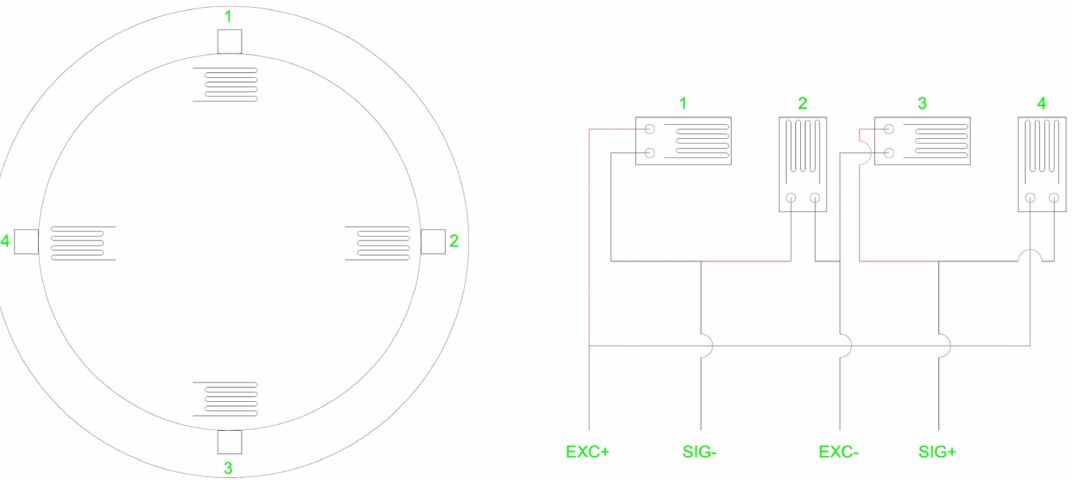
Figure 9. PCB Design and Circuit and Strain Gauge Attachment Directions(1: Horizontal, 2: Vertical, 3: Horizontal, 4: